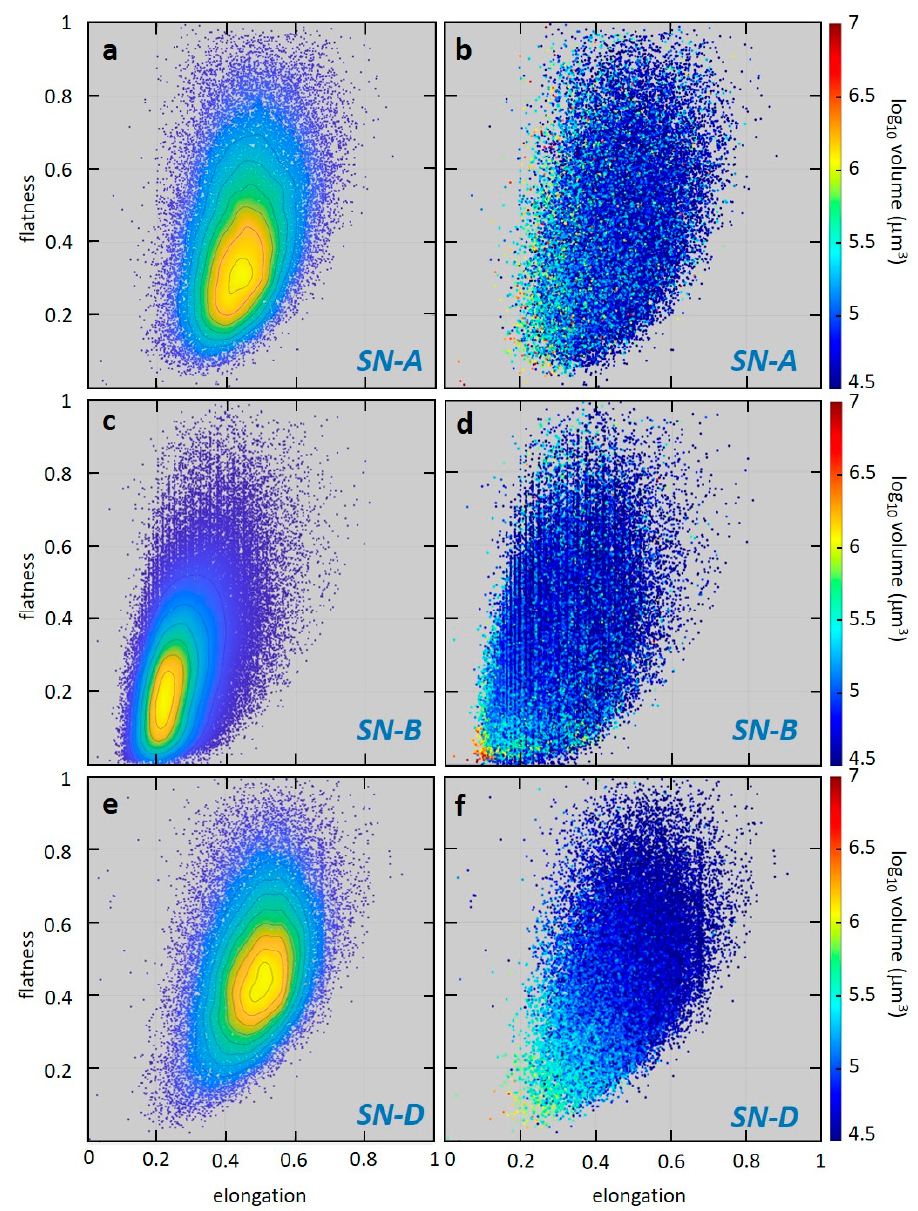
Figure 8. Vesicles’ flatness vs. elongation scatter diagrams. In the diagrams of the left panels a density function has been overlapped. Yellow indicates the highest concentration of points, blue the lowest. In the diagrams on the right the different colors indicate different vesicles’ size (expressed as base 10 logarithm of the volume). ( a , b ): Sample SN-A; ( c , d ): sample SN-B; ( e , f ): sample SN-D.